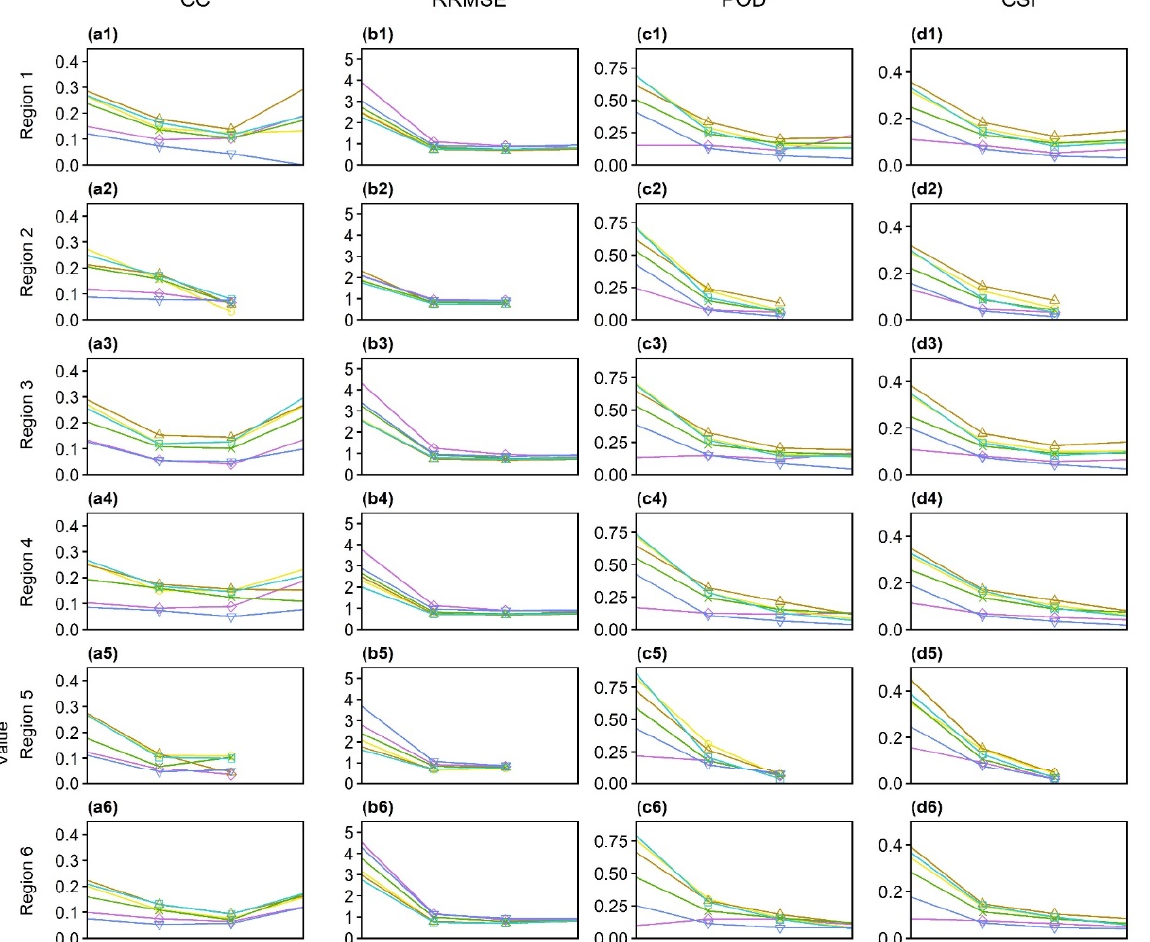
Figure 7. Mean values of four statistical metrics of precipitation products at four precipitation levels in different regions between 2015 and 2019. From left to right: (a1–a9) CC, (b1–b9) RRMSE, (c1–c9) POD and (d1–d9) CSI. Violent rain is not counted in R 2 and R 5 due to the low frequency of events. 3.2.3. Performance of Precipitation Products in Time Series Figure 8 shows the time series of daily precipitation of rain gauges and six products in the nine regions. It is evident that the amount and pattern of precipitation vary signifi ‐ cantly between the nine regions of mainland China. R 2 is the driest region with low daily precipitation throughout the year, and small biases are found between the precipitation products and real observations. Most products show significant overestimation in R 5 ,